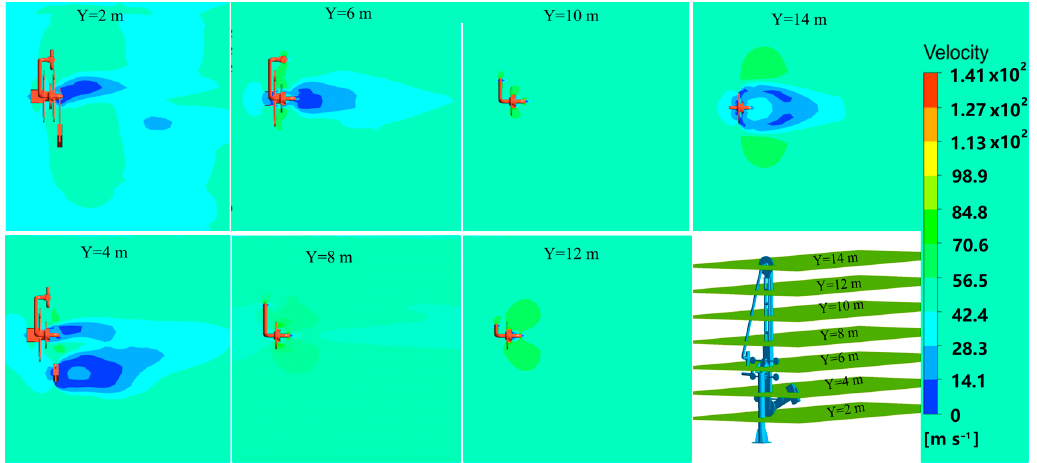
Figure 16. Velocity distribution in di ff erent sections of the LNG marine loading arm fl ow fi eld.